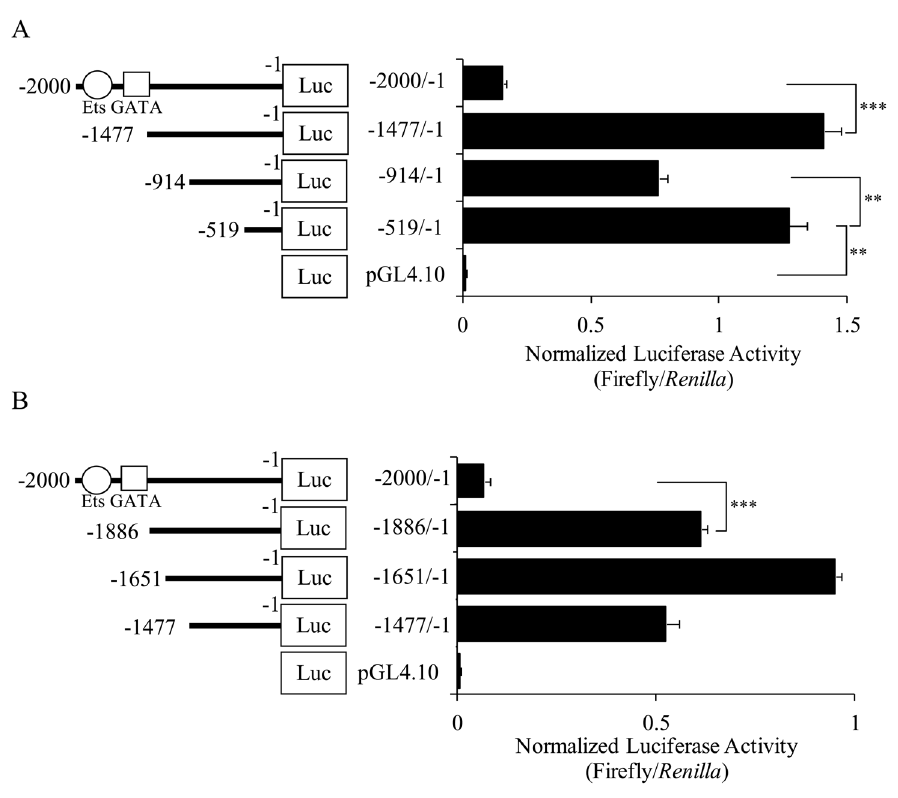
Figure 3. Deletion analysis of the ck b promoter in MCF-7 cells. (A) Results from the first round of luciferase assays with 5 9 -truncated ck b promoter constructs (ranging from 2 2000 to 2 519). (B) Results from the second round of luciferase assays with 5 9 -truncated ck b promoter constructs (ranging from 2 2000 to 2 1477). The schematic structures of the step-wise 5 9 deletion constructs are shown on the left. Ets and GATA binding sites investigated in this study are indicated by an open circle and open square, respectively. Each bar represents the mean ¡ SEM from three independent experiments performed in triplicate (* p , 0.05; ** p , 0.01; and *** p ,